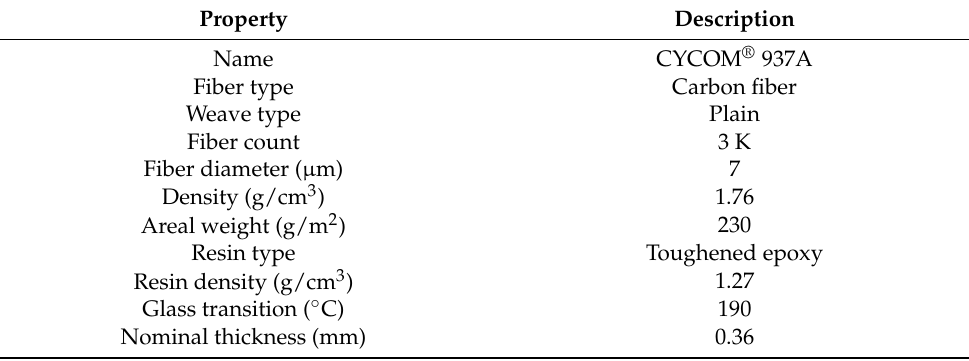
Table 1. Properties of the prepreg used in this study